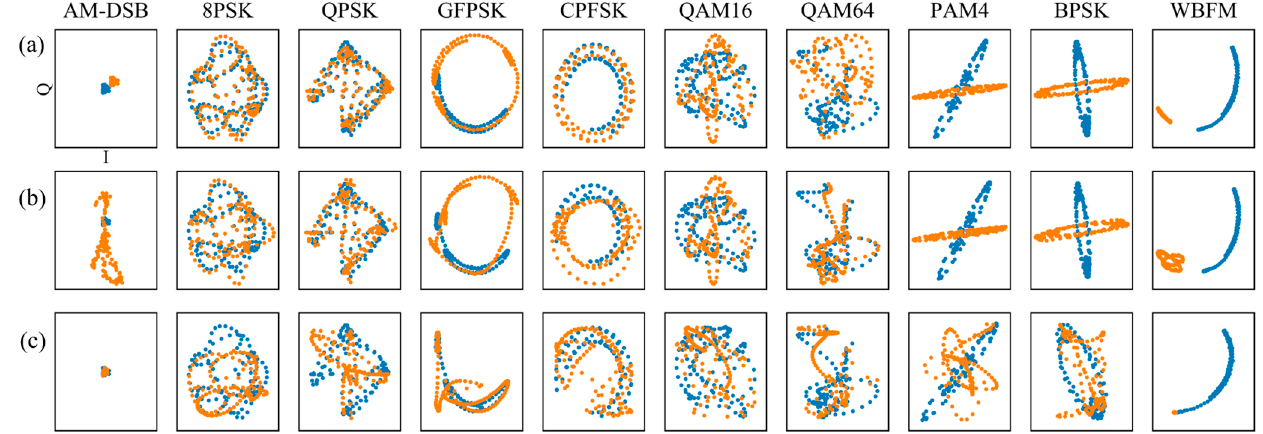
Figure 1. Comparison of constellation of modulated signals after three time series transformations. The original signal constellation diagram is highlighted in blue and the converted signal constellation diagram is displayed in orange. ( a ) Scaling; ( b ) magnitude warping; ( c ) time warping.